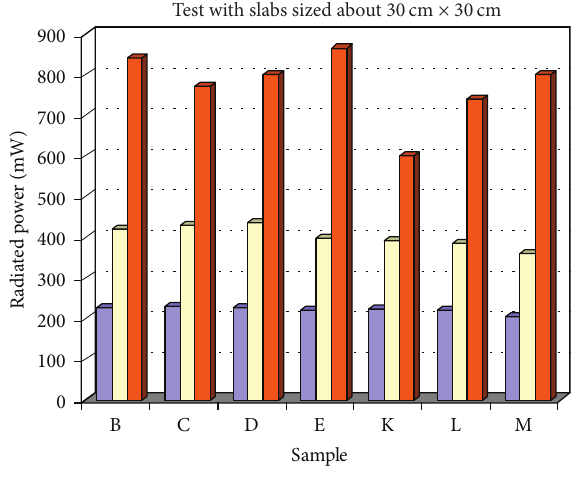
UHFHF and LFUHFHF and F 15: Experimental results showing the radiated power in the on/off detection strategy Pure water